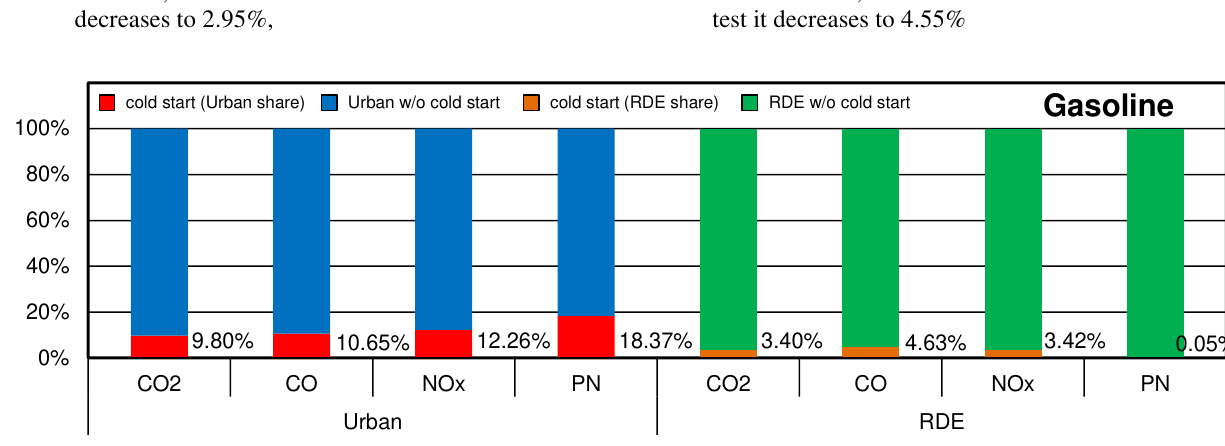
Fig. 14. The share of emissions exhaust compounds during the cold start (300 s) in relation to the urban part of RDE test and the entire RDE test for gasoline engine